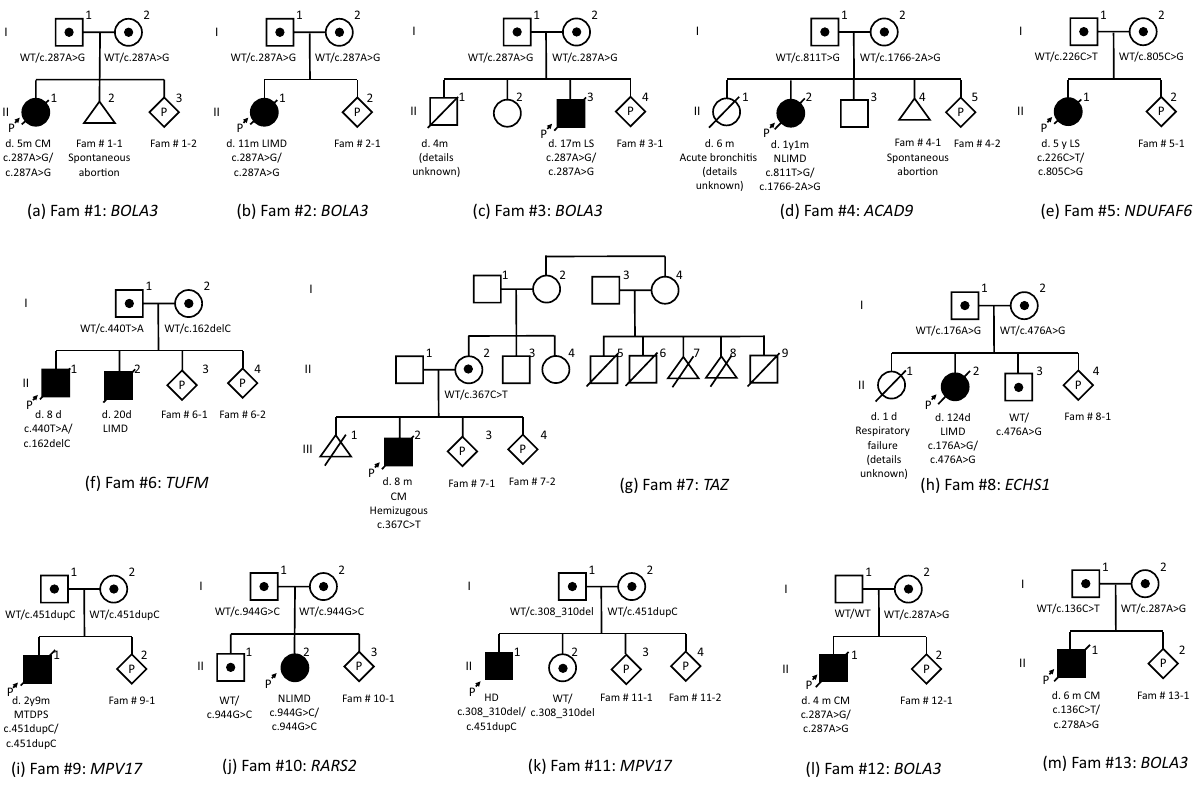
Figure 2. Family tree of 13 probands. One family had X chromosome-linked gene mutation; the other 12 families had autosomal recessive gene mutations. In our cohort, there was no consanguineous couple. Fam family, CM cardiomyopathy, LIMD lethal infantile mitochondrial disease, NLIMD non-lethal infantile mitochondrial disease, LS Leigh syndrome, HD hepatic disease, MTDPS mitochondrial DNA depletion syndrome, WT wild type, m month, d day, y